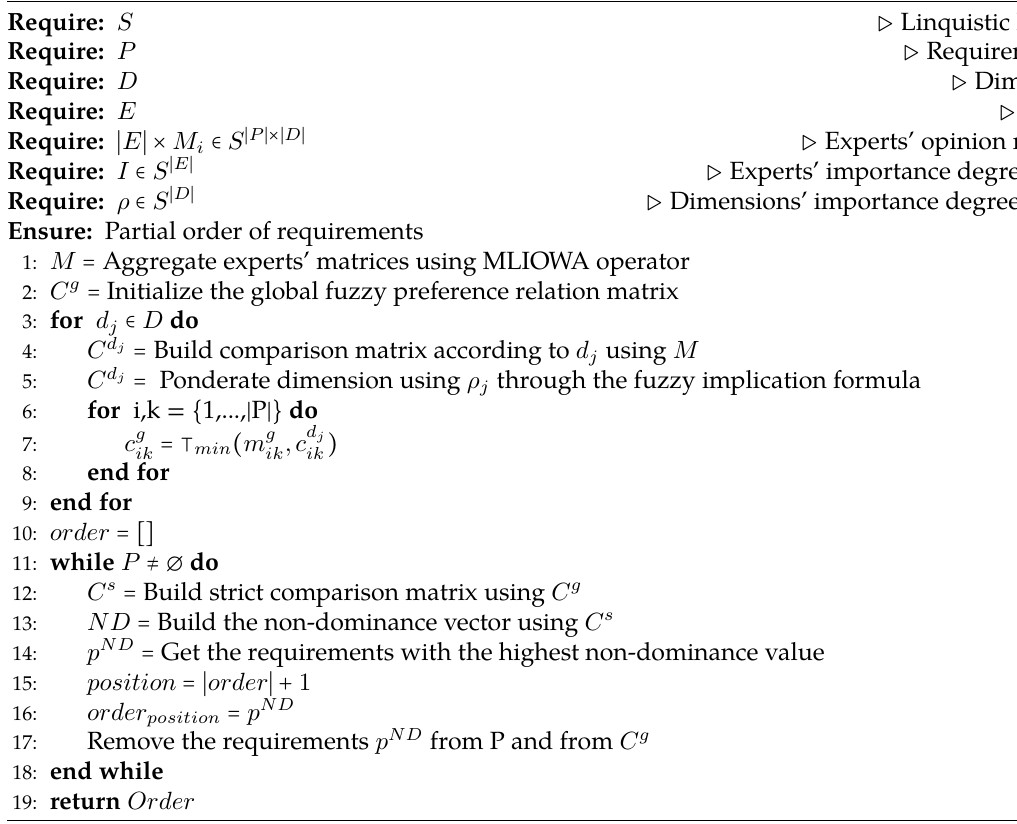
Algorithm 1 Proposed prioritization